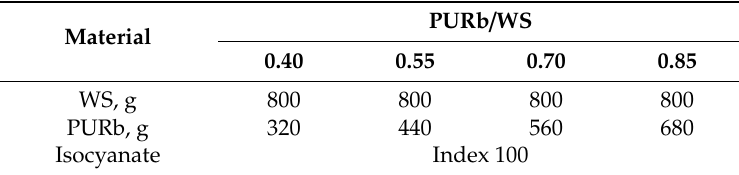
Table 2. Compositions of PUR biocomposite